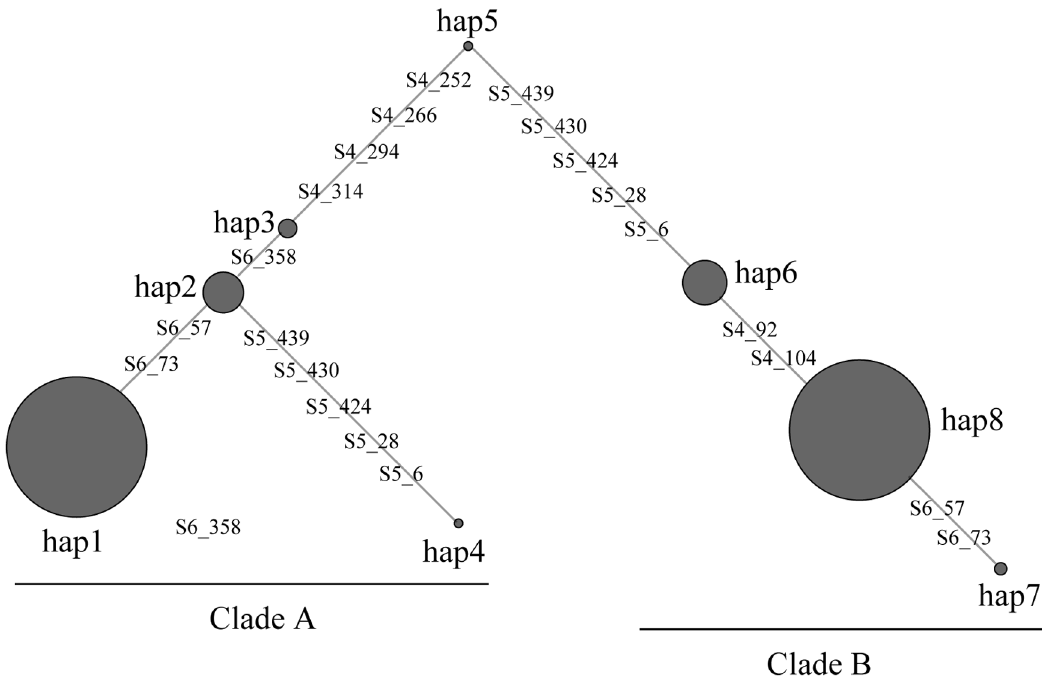
Figure 3. Median-joining network showing the genealogy of the BM Block 3 haplotypes in the BM population. Each haplotypes is shown as a circle with the size of the circle representing the haplotype frequency. Nucleotide differences between haplotypes are shown on the branches of the network.